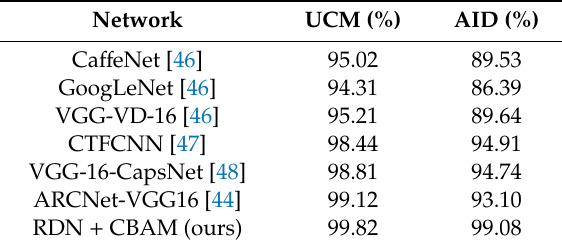
Table 5. Accuracy comparison of other state-of-the-art scene classification methods on UCM and AID